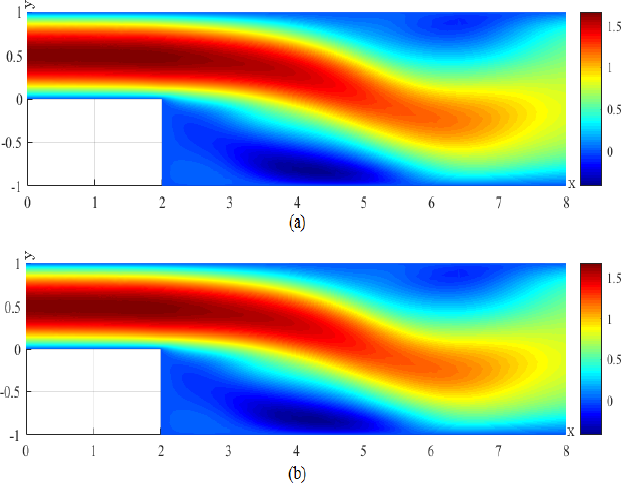
Figure 2. ( a ) The CNMFE solution for u at t = 4. ( b ) The RDRCNMFE solution for u at t =